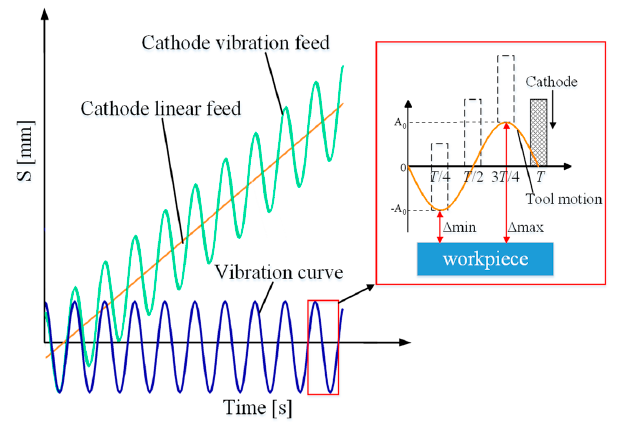
Figure 3. The law of cathode movement.